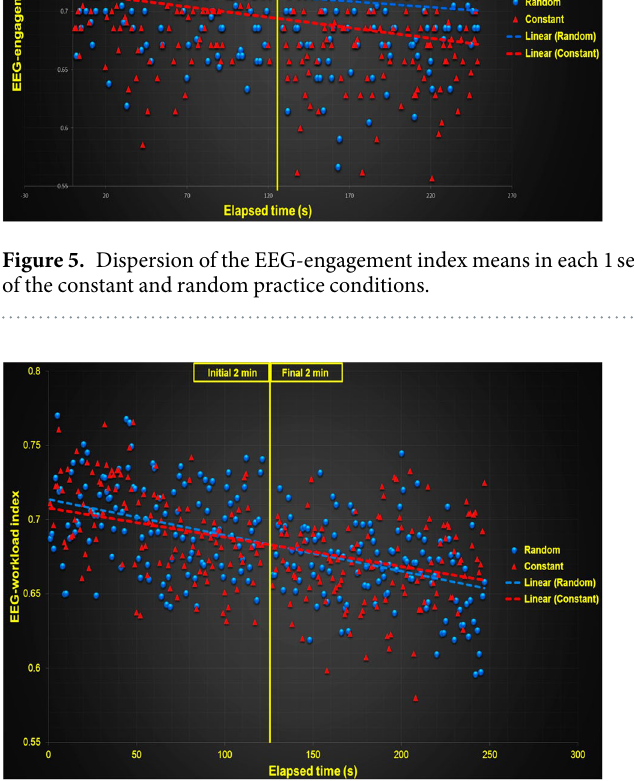
Figure 6. Dispersion of the EEG-workload index means in each 1-second interval of the initial and final part of the constant and random practice conditions.